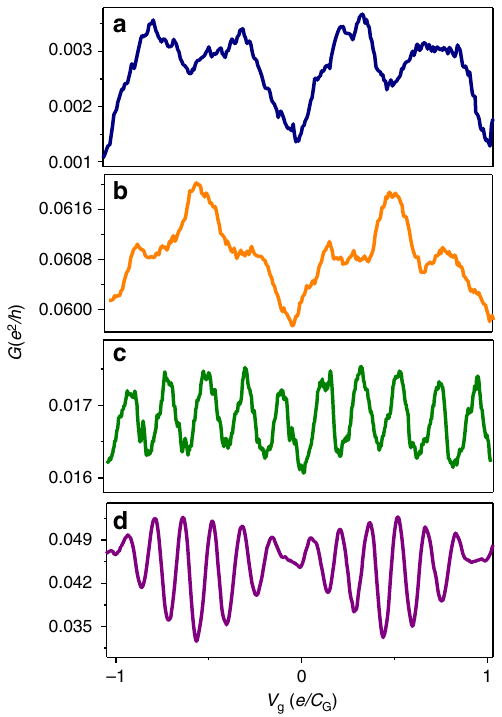
Fig. 2 Multiple harmonics. G ( V g ) for four different single-electron transistors. All curves show conductance oscillations with a periodicity P CB , and additional oscillations with frequencies that are the second a , third b , fi fth c , and sixth d harmonics of f